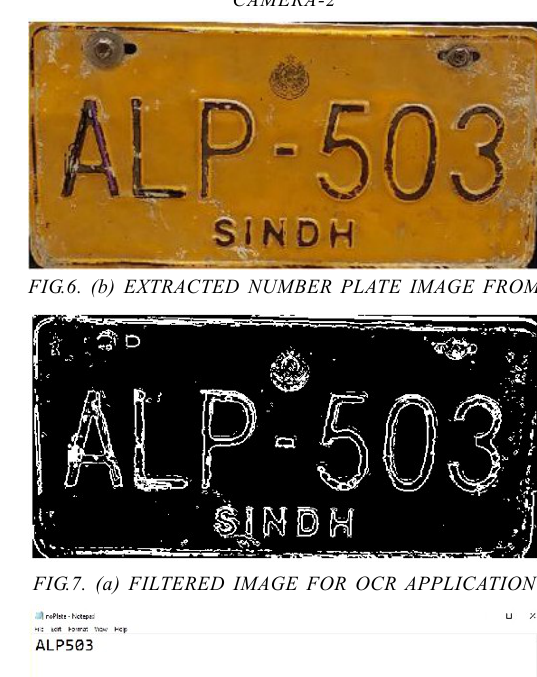
FIG.7. (a) FILTERED IMAGE FOR OCR APPLICATION